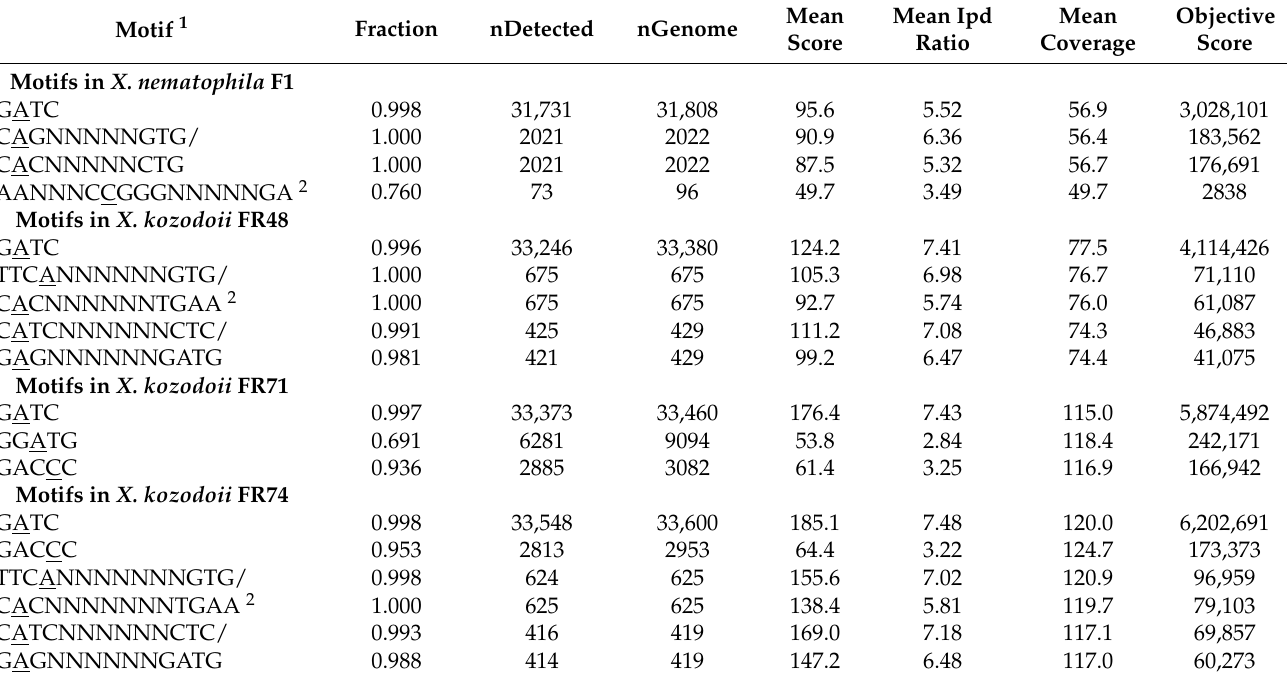
Table 1. Methylated motifs detected by SMRT sequencing in Xenorhabdus